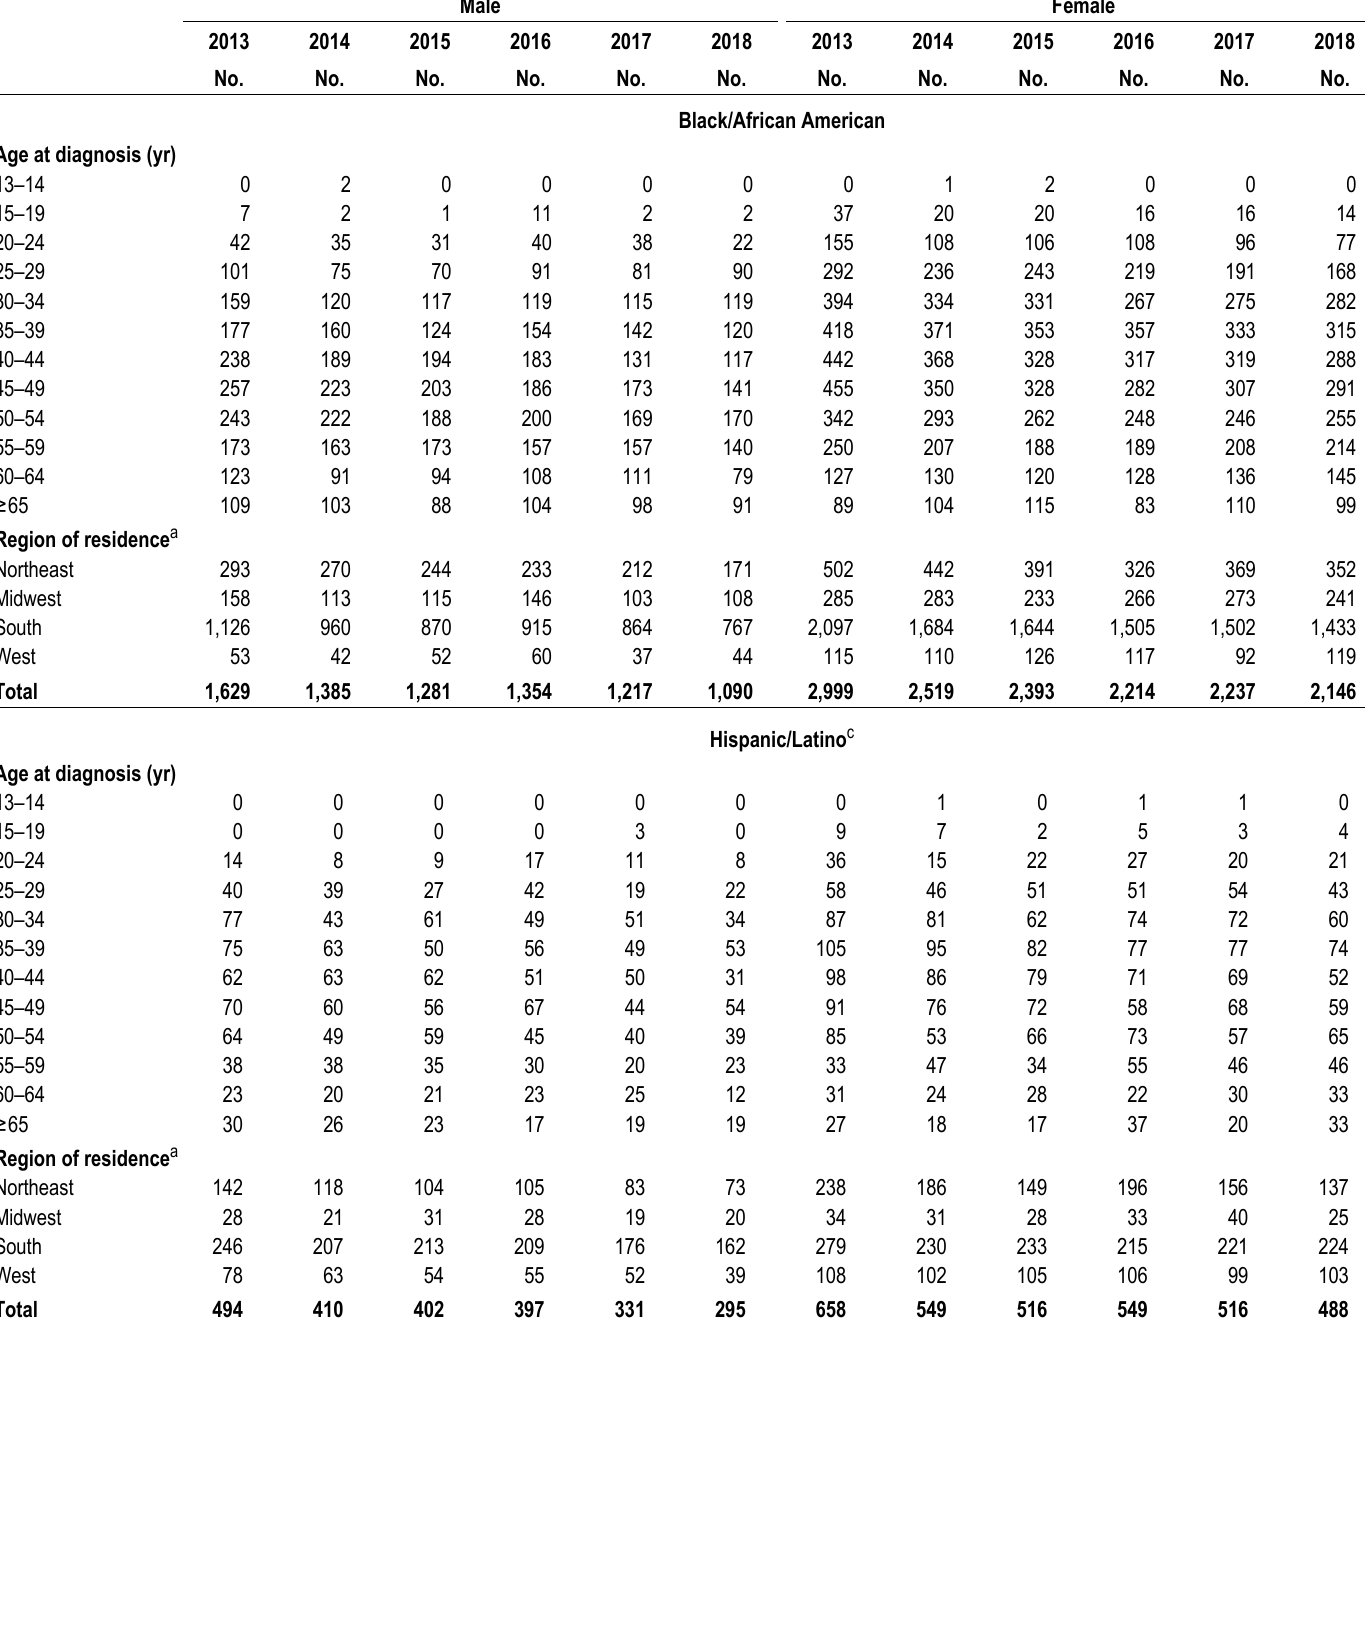
Table 12a. Stage 3 (AIDS) attributed to heterosexual contact, by selected characteristics, 2013–2018—United States (cont) Male